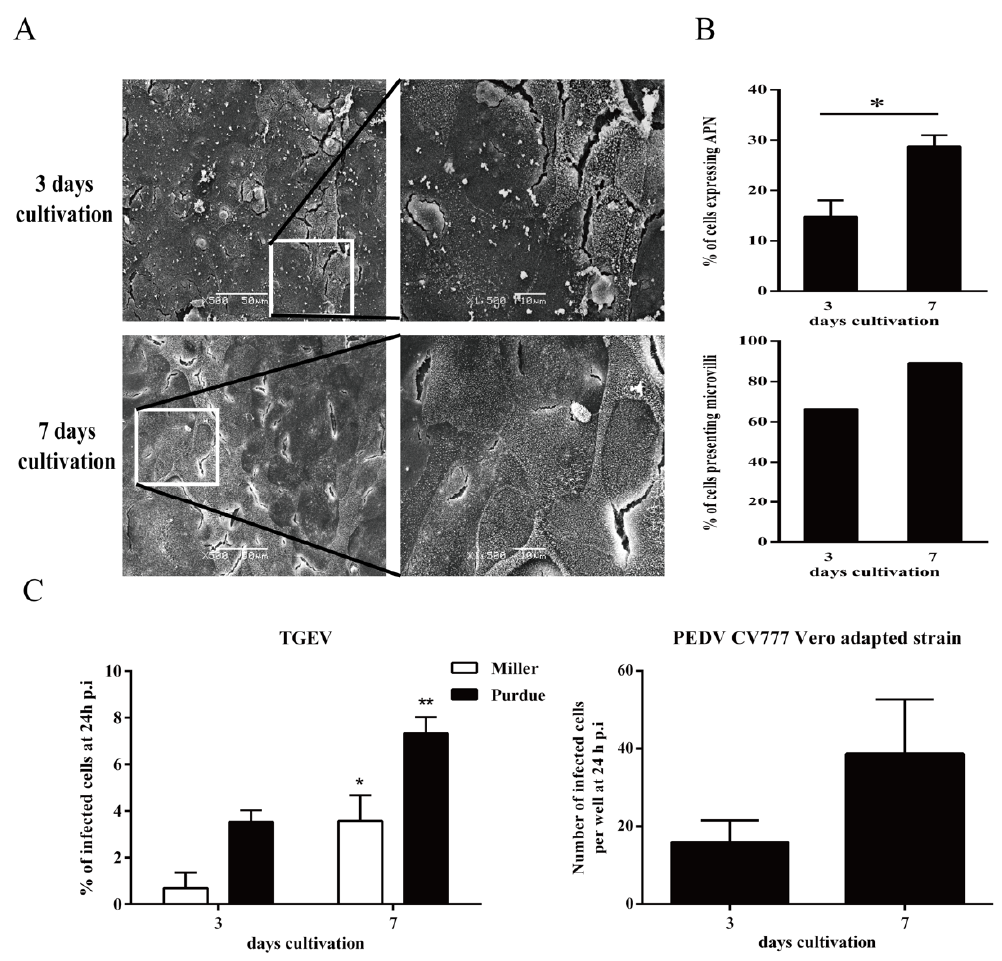
Figure 1. Effect of cultivation age on the percentage of microvilli positive cells and susceptibility to virus infection. ( A ) At three days and seven days cultivation, the microvilli on the surface of primary enterocytes were detected by scanning electron micrograph. ( B ) The percentages of microvilli positive cells and aminopeptidase N (APN) positive cells were counted. ( C ) At three days and seven days cultivation, cells were inoculated with Porcine epidemic diarrhea virus (PEDV; 10 5.6 TCID 50 / mL) and transmissible gastroenteritis virus (TGEV; m.o.i. = 1). Percentage of infection was measured 24 h post inoculation. Data are expressed as mean ± standard deviation (SD) of the results of three separate experiments. Statistically significant differences in comparison with data from three days cultivation are presented as * p < 0.05 or ** p < 0.01.